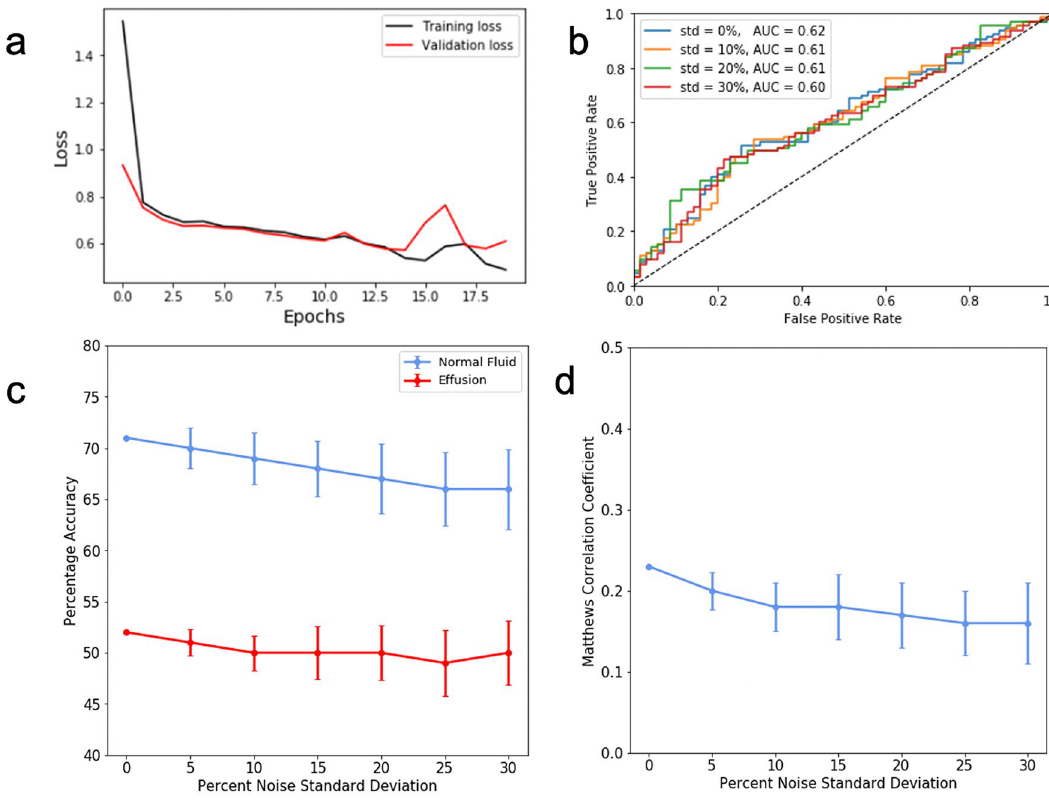
Figure 4. ( a ) Learning curves for the training and validation data sets of the dNN. ( b ) The testing data was degraded with additive Gaussian noise with a standard deviation varying from 0 to 30% of the maximum pixel intensity. ROC curves were recorded, and the AUC was calculated. ( c ) The same method as panel b, mean and standard deviation of accuracy was recorded for each class. ( d ) The same noise addition method as panel b, mean and standard deviation of Matthews correlation coefficient was recorded with additive noise.